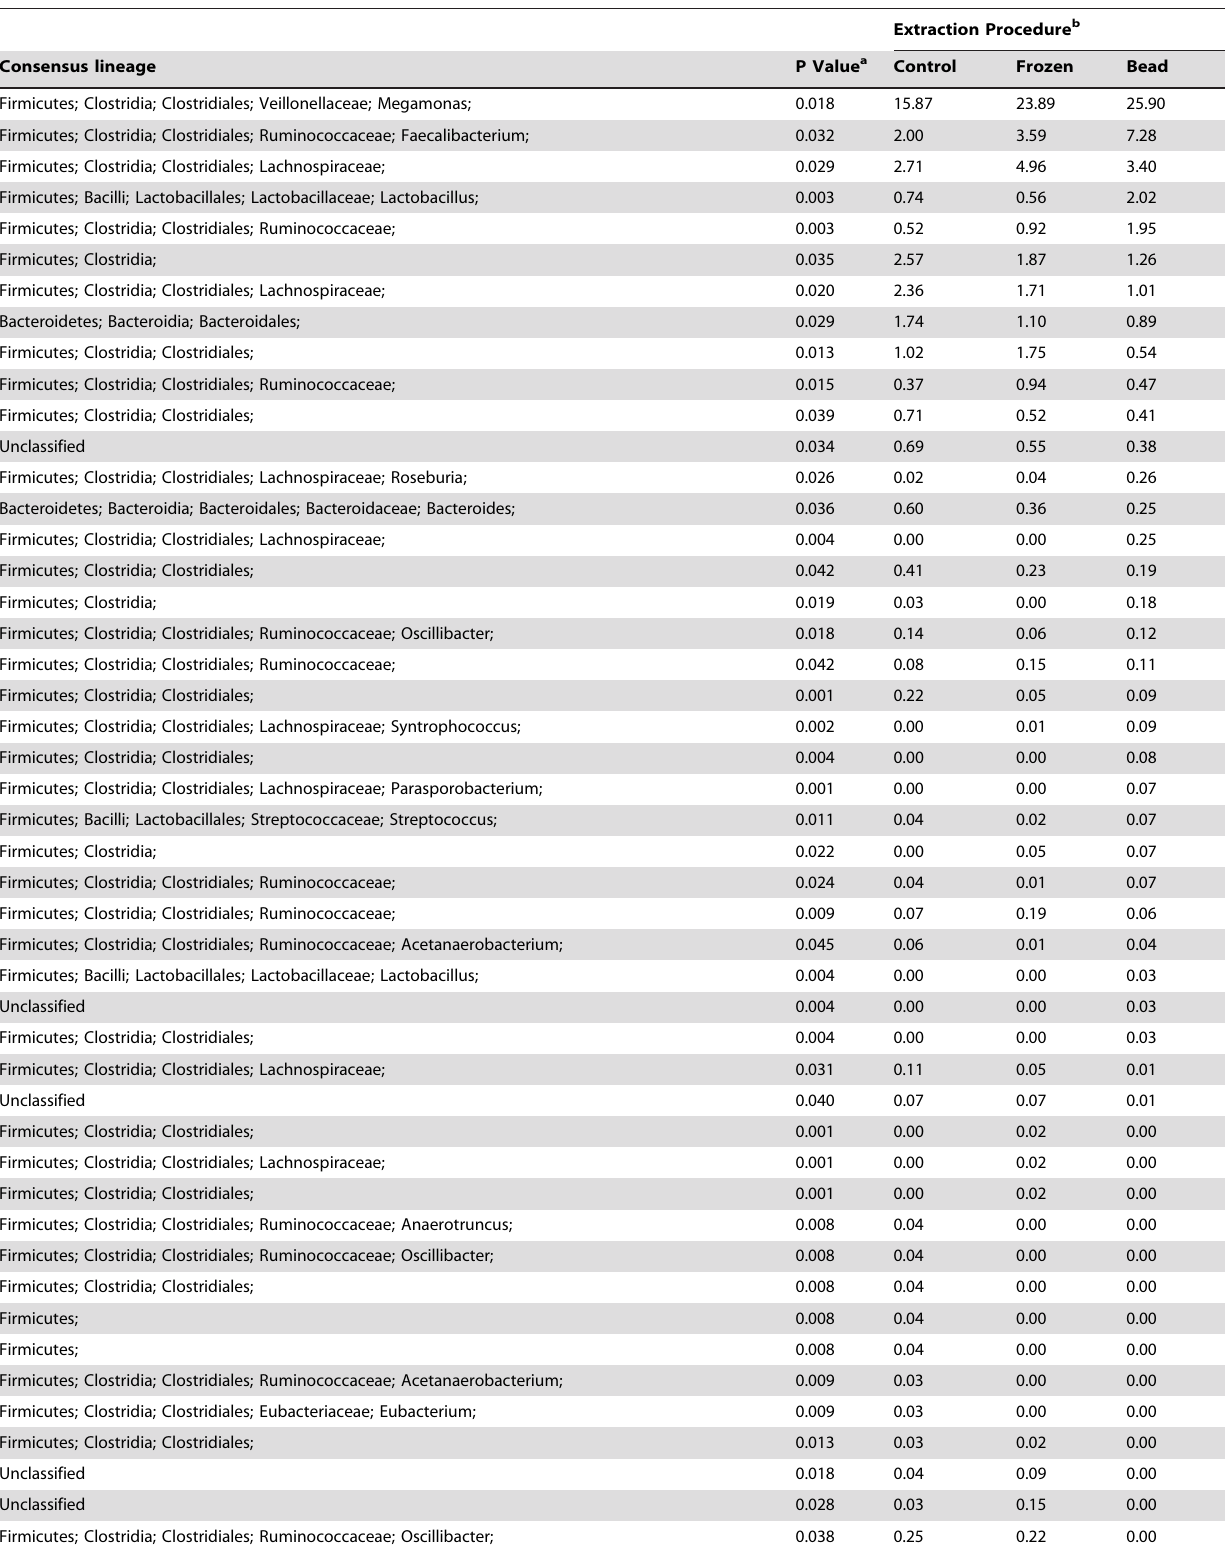
Table 5. OTUs which showed significant differences when different extraction methods were